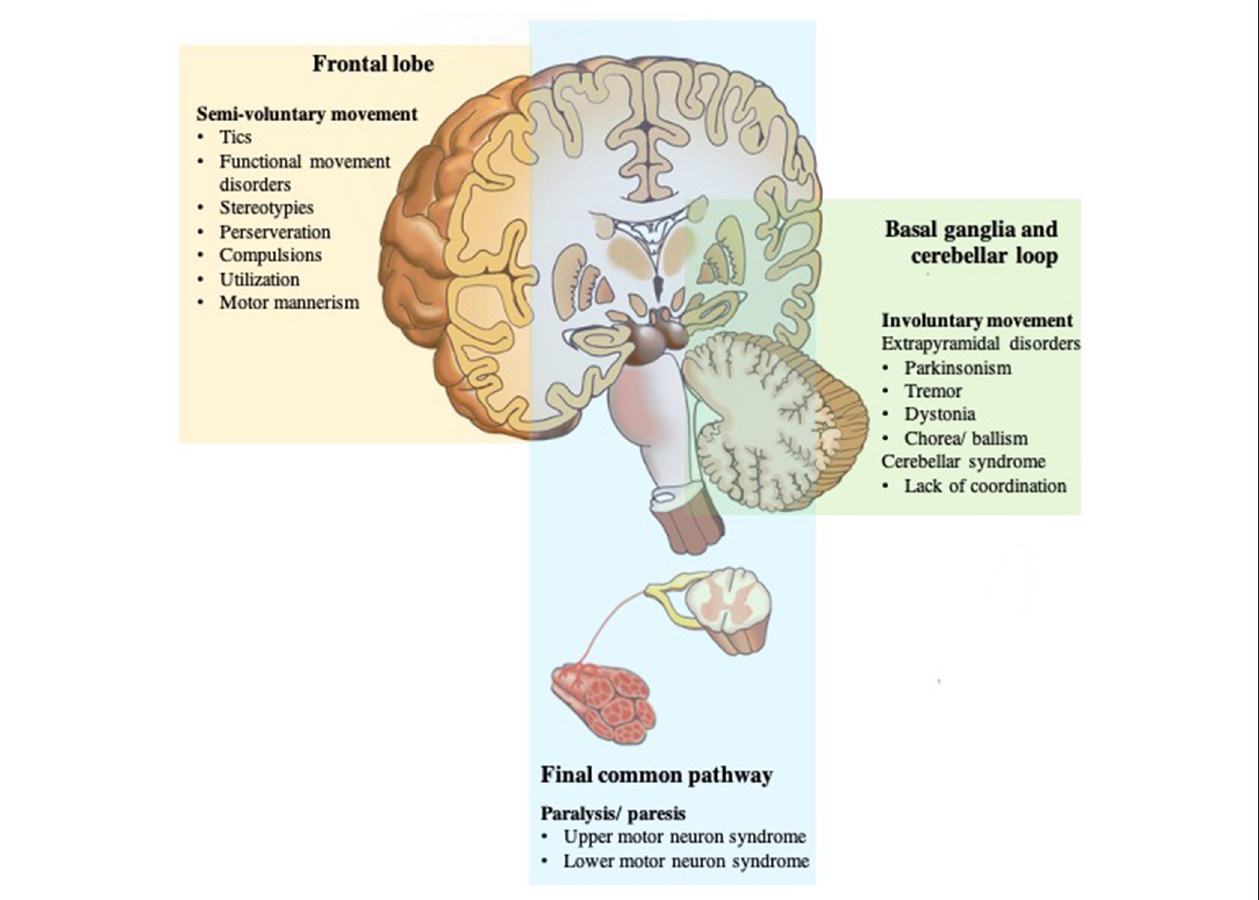
FIGURE 3 | Disorders of the motor system. The motor system is deconstructed into component parts, but they work together to produce movement that we take for granted until there is a problem. Any damage of the final common pathways (shown in blue) can cause upper or lower motor neuron syndromes resulting in an inability to move due to paresis or paralysis. Dysfunction of the two parallel loops (shown in green) disturbs smooth movements resulting in pathologic involuntary movement disorders; basal ganglia loop dysfunction with extrapyramidal disorders; cerebellar loop dysfunction with a lack of coordination. While any damage of the frontal lobe or final common pathways input (shown in yellow) appears to involve self-initiation and conscious awareness of movement, and thus, results in no sense of voluntariness for an otherwise voluntary-appearing movement.